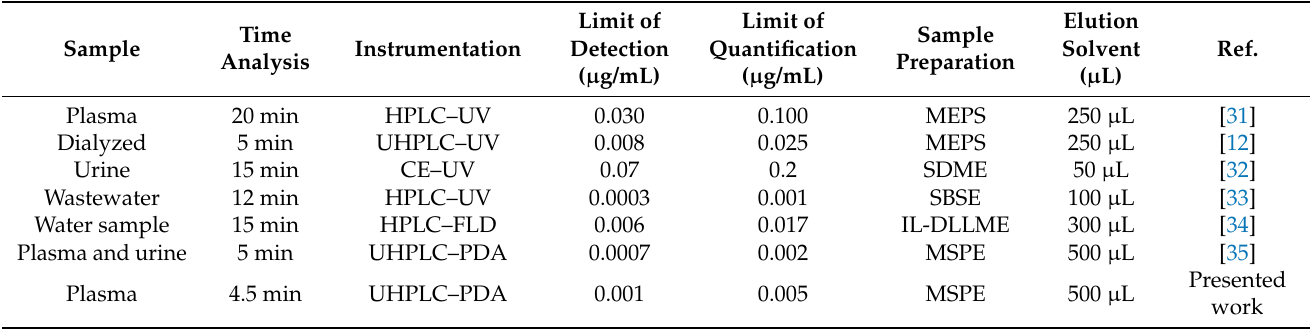
Table 2. Comparison of the proposed method with reported methods for the determination of